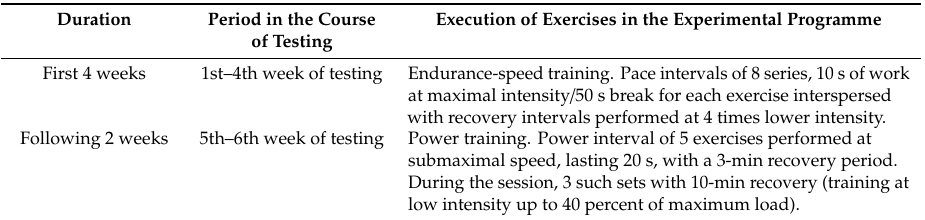
Table 2. Course of afternoon training session (60 min) in the experimental (hypoxia) and control (normoxia) groups—description of exercises in Table